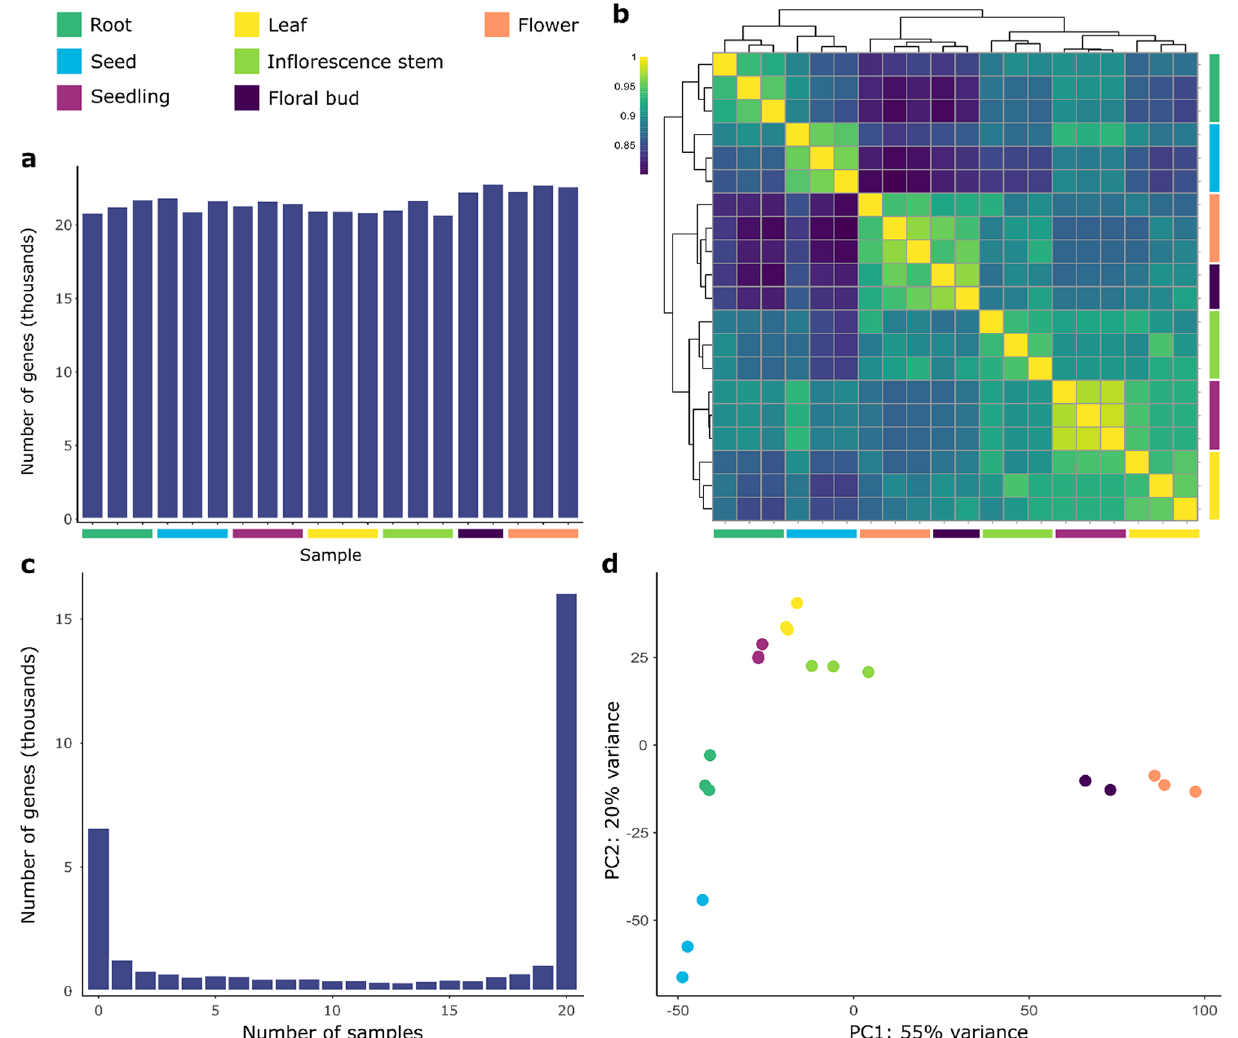
Figure 1. Overview of P. veris transcriptomic data. Samples of the same tissue are color coded, following the color scheme in the top-left corner of the figure. ( a ) Number of transcriptionally active genes (i.e. genes with normalized counts ≥ 4) per sample. ( b ) Heatmap of hierarchical clustering of the samples based on their pairwise similarity (estimated as Spearman’s rank correlations) for all 20 samples, with color scale indicating the degree of correlation. ( c ) Number of genes expressed in any given number of samples. ( d ) PCA plot for the 20 RNA-seq samples. Samples belonging to the same tissue cluster together. The first principal component (x-axis) separates samples of reproductive tissues (floral bud (purple) and flower (salmon)) from all remaining